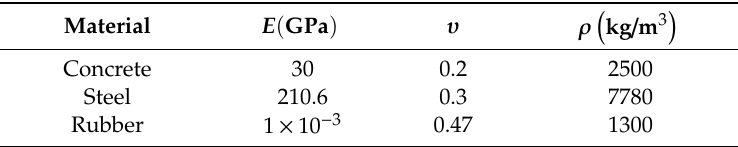
Table 1. Material parameters of the